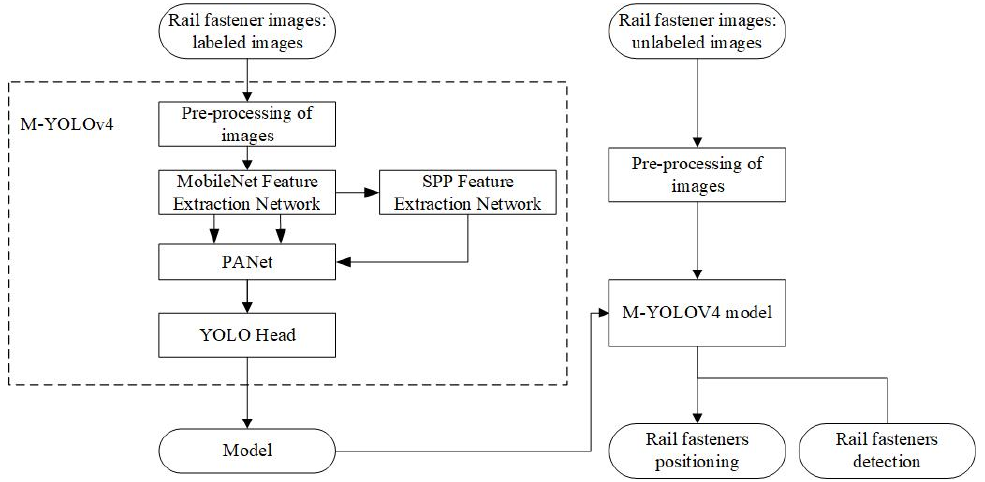
Figure 3. Flow diagram of M-YOLOv4.